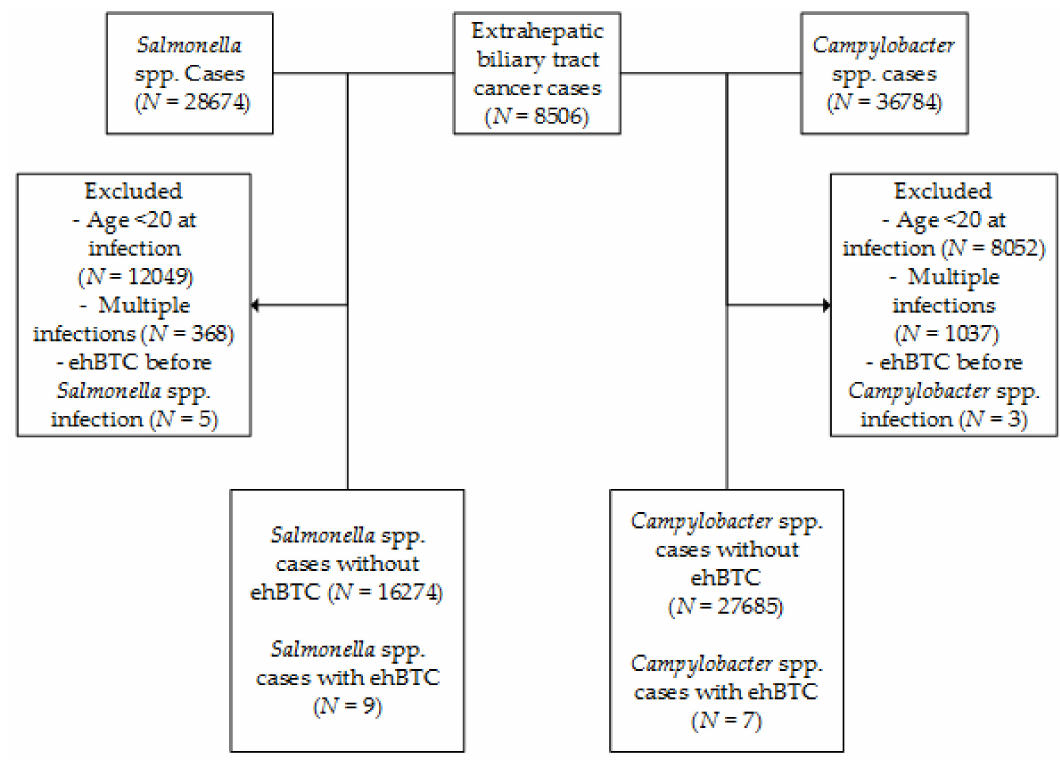
Figure 1. Cohort selection. ehBTC = extrahepatic biliary tract